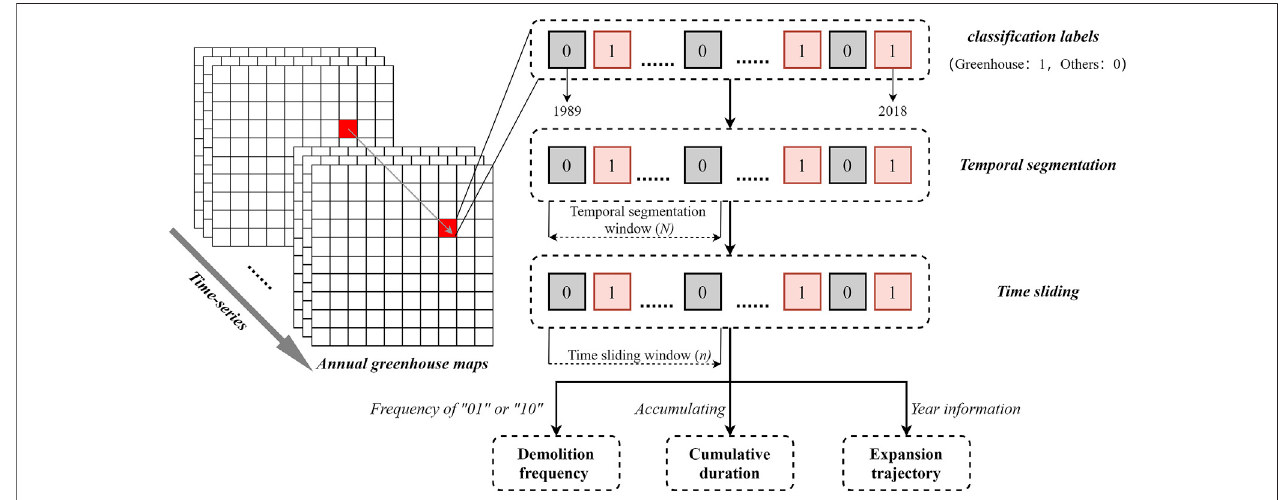
FIGURE 2 | The Time-series segmentation and sliding algorithm